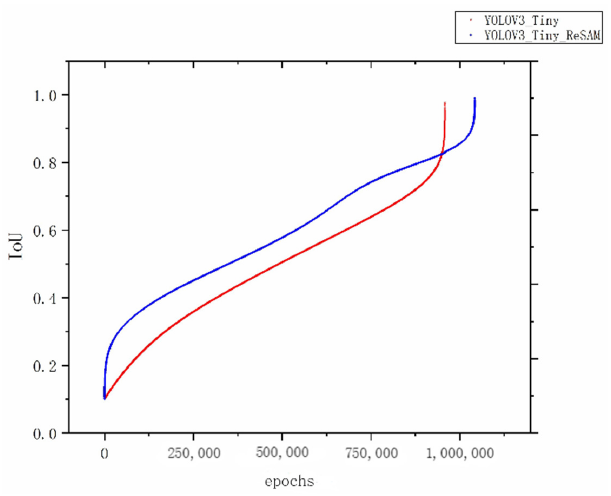
Figure 13. IoU curve.